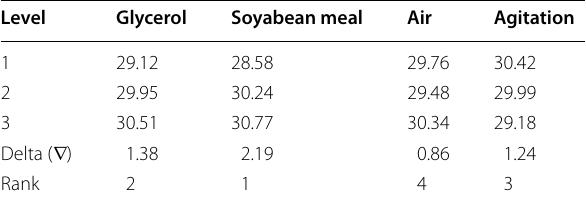
Table 3 Response Table for Signal to Noise Ratios of biomass (DCW: g/L) production by Streptomyces sp. RA-WS2